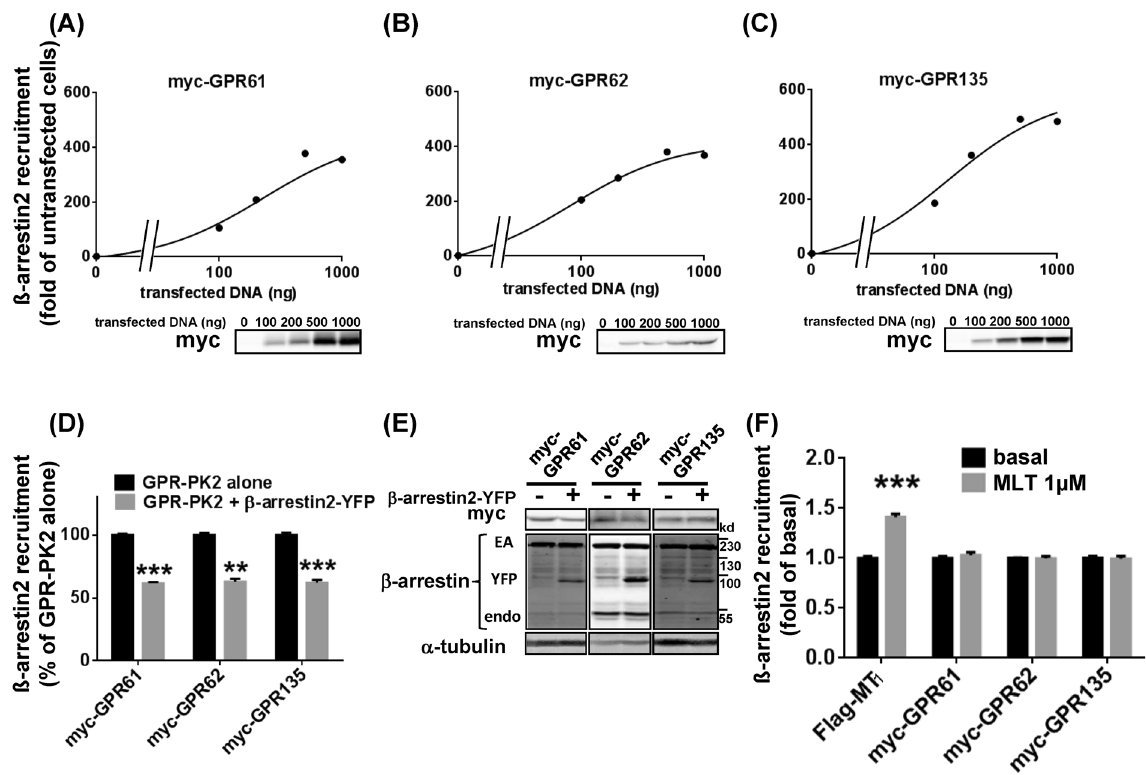
Figure 3. Agonist-independent association between β -arrestin2 and GPR61, GPR62 and GPR135. ( A–C ) ß-arrestin recruitment was determined in HEK-arrestin2-EA cells stably expressing the ß-arrestin2-EA fusion protein and transfected with different quantities of myc-GPR61-PK2 ( A ), myc-GPR62-PK2 ( B ) or myc-GPR135-PK2 ( C ) expression vectors. Expression levels were monitored by western blot. ( D , E ) ß-arrestin2 competition assay. HEK-arrestin-EA cells were transfected with 500 ng of GPR-PK2 vectors with or without an additional 500 ng of ß-arrestin2-YFP vector ( D ). Expression levels of myc-GPR61, myc-GPR62 and myc-GPR135 and ß-arrestins were monitored by western blot ( E ). Effect of melatonin (1 µ M) on ß-arrestin2 recruitment to GPR61, GPR62 and GPR135 (1 ug) ( F ). Flag-MT 1 -PK2 was used as a positive control. Western blots shown are representative and have been performed for each experiment. Data are expressed as mean ± SEM from 3 independent experiments performed in triplicates. ** P < 0.01, *** P <